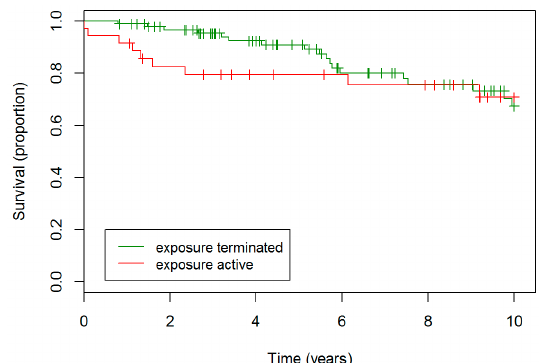
Figure 5. Survival in HP patients based on active exposure throughout follow-up . No significant differences were observed